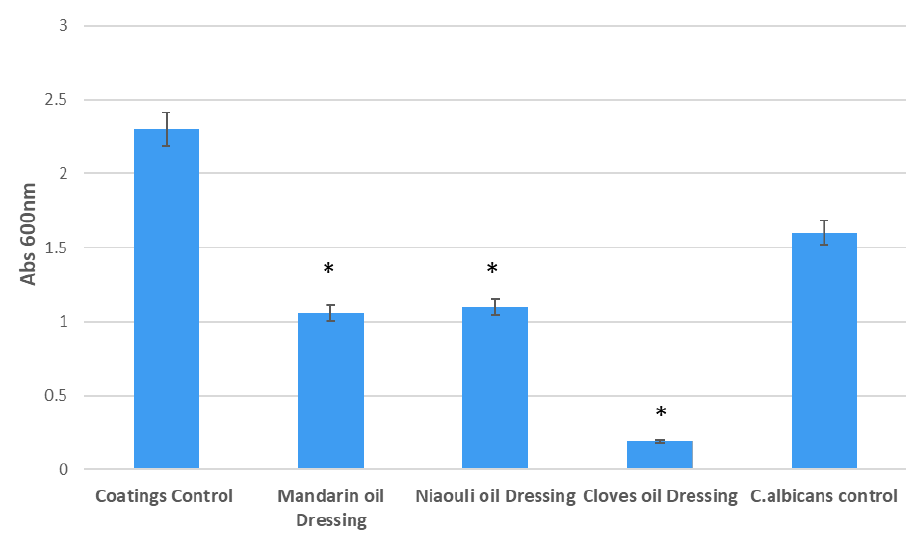
Figure 11. Growth of planktonic cultures of C. albicans in the presence of wound dressings coated with EOs functionalized silver nanoparticles (NPs). Coatings Control—dressing modified with silver NPs, Mandarin oil Dressing—dressing modified with silver NPs and mandarin EO, Niaouli oil Dressing—dressing modified with silver NPs and niaouli EO, Cloves oil Dressing—dressing modified with silver NPs and clove EO. * p < 0.05 (control coatings vs. NPs and EOs coated samples for each